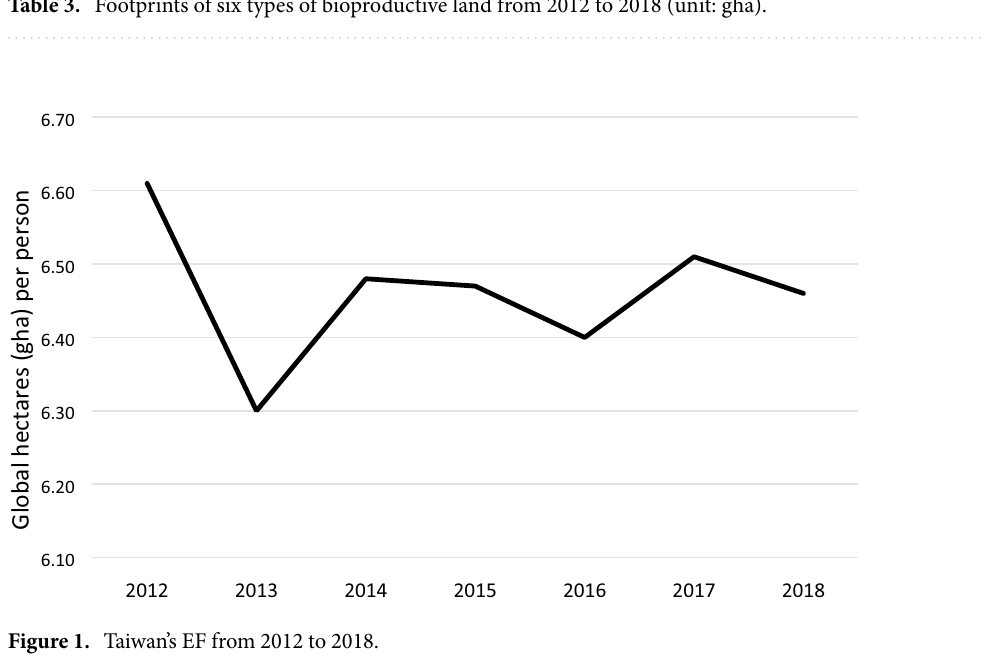
Figure 1. Taiwan’s EF from 2012 to